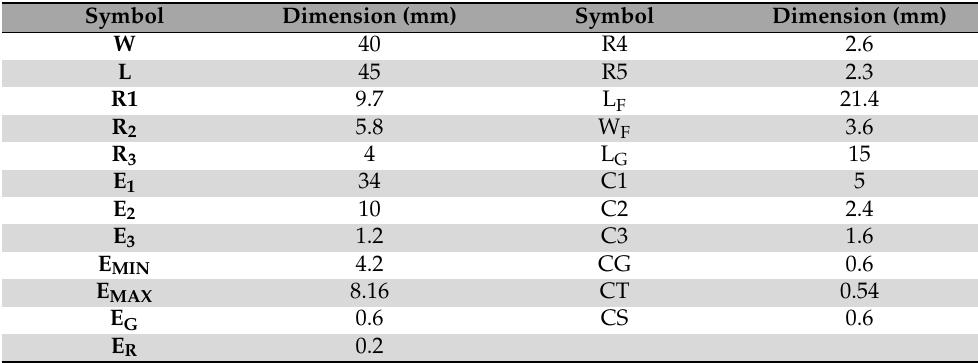
Figure 1. Labelled geometry of the triple band-notched super wide band (SWB) antenna front view and back view made on RT-Duroid 5880 substrate with dielectric constant of 2.2, tan δ = 0.0009, and thickness of 1.57 mm. Table 1. Optimal values for different parameters of the designed triple band-notched SWB an- tenna structure.